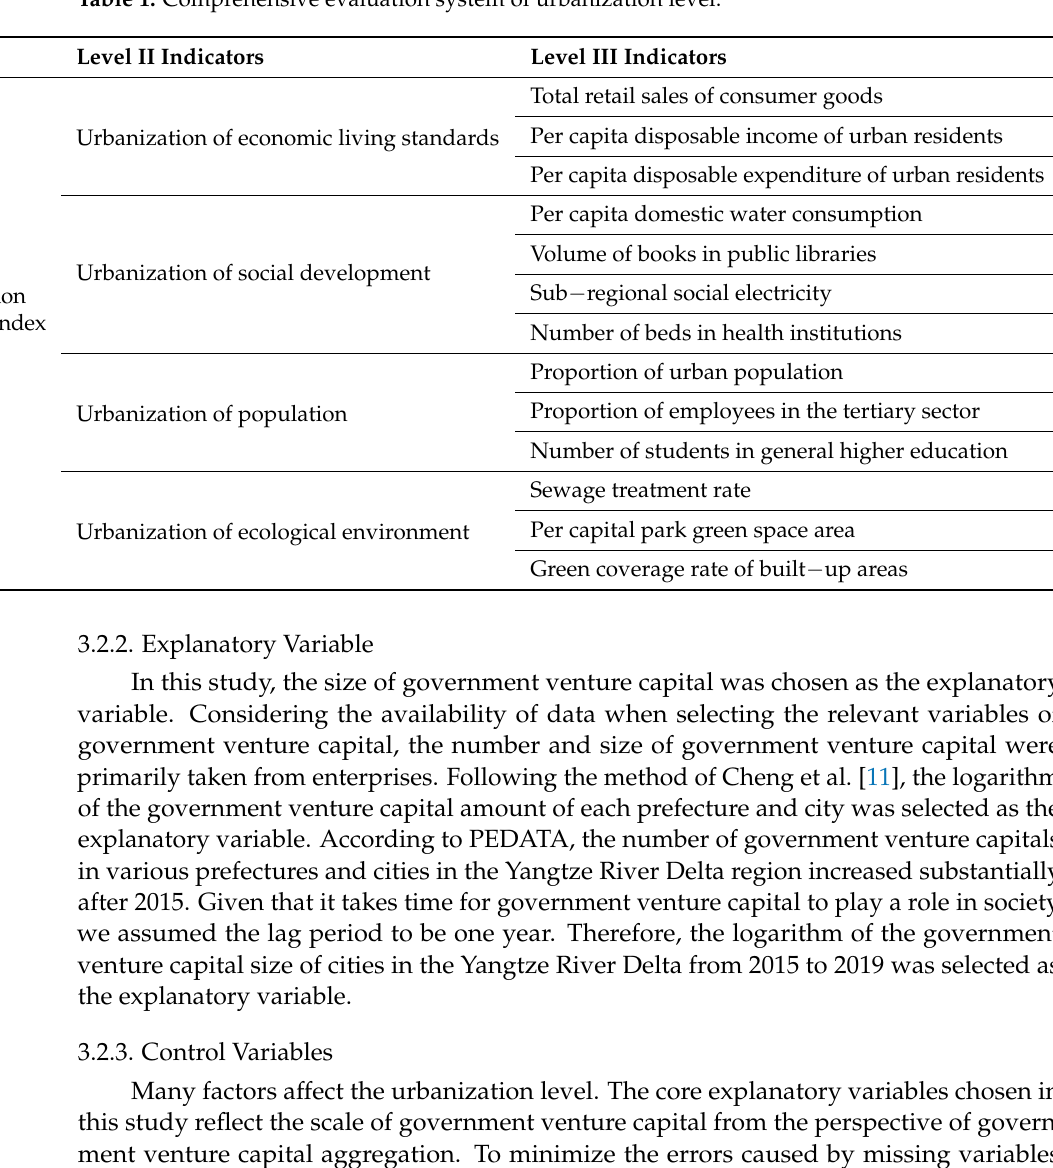
Table 1. Comprehensive evaluation system of urbanization